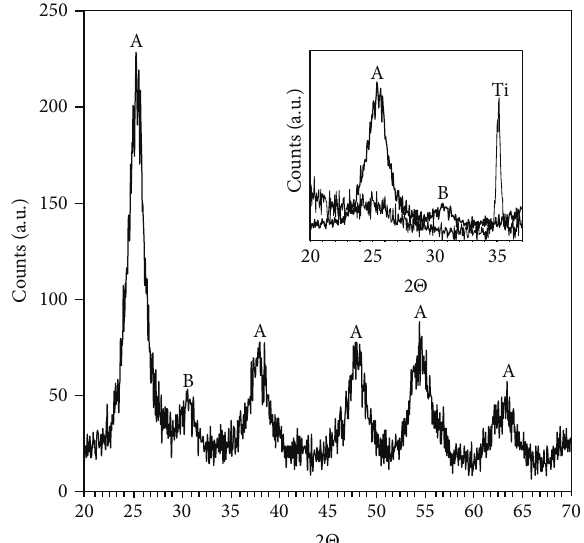
Figure 1: X-ray diffraction of TiO 2 -synthesised nanoparticles with 8 or 22 nm size. The particles were dried at 120 ∘ C for 16h prior to the analysis. Diffraction peaks marked with A correspond to anatase while B stands for brookite. The inset shows enlargement of the diffraction pattern for the particles dispersed on Ti (thin line). The film was washed and allowed to dry at room temperature